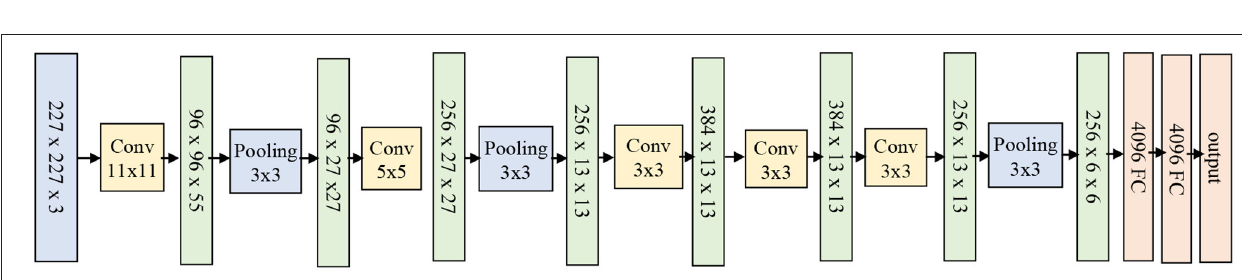
FIGURE 5 | The GoogLeNet inception modules. Left: Naïve version of inception module. Right: Inception module with dimensionality reduction.